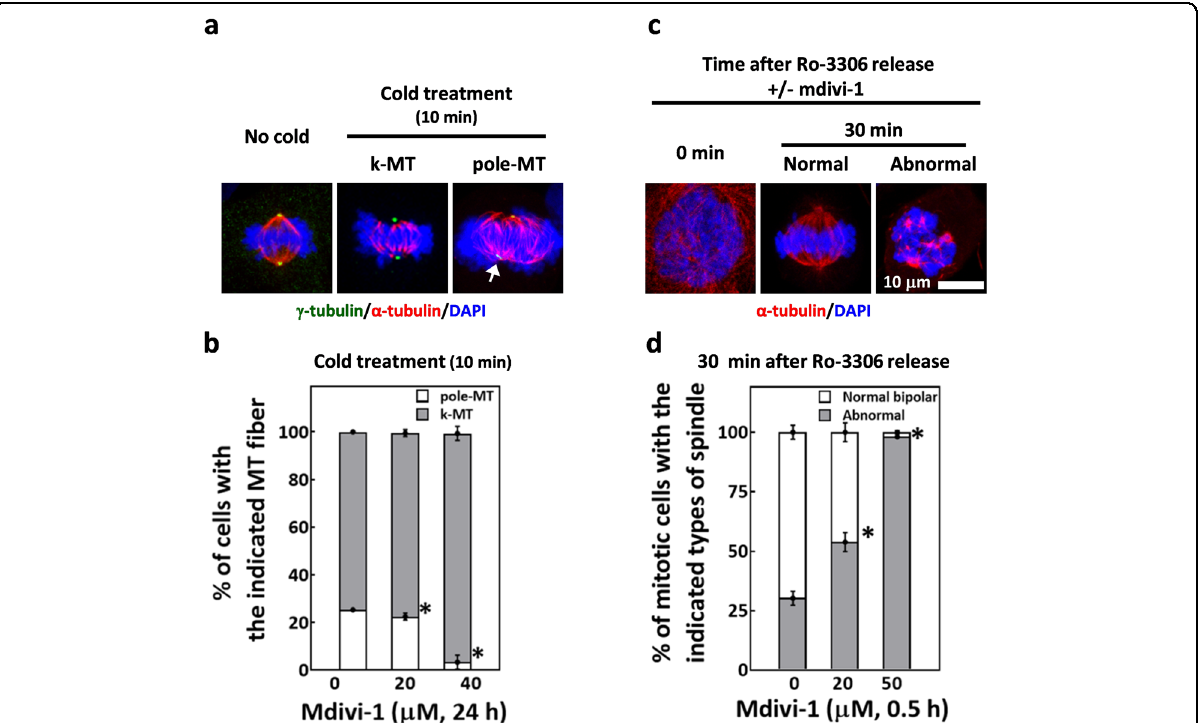
Fig. 6 Mdivi-1 sensitizes microtubules to cold-induced disassembly and immediately disrupts spindle assembly upon mitosis entry. a Representative image of cells fi xed without cold treatment (no cold) and those fi xed after 10 min cold treatment are shown. For 10-min cold- treated cells, images are representative of those with kinetochore-microtubule (k-MT) and those with spindle microtubule remnants at the spindle pole (pole-MT, white arrow). The spindle was revealed by immunostaining for γ -tubulin (green), α -tubulin (red), and chromosomes (blue). b Mdivi-1- sensitized cells to cold-induced disassembly of spindle pole microtubules. The cells were treated with mdivi-1 as indicated, followed by 10 min cold treatment. Cells were then subjected to analysis of mitotic spindles. The percentages of cells containing the indicated types of microtubule are shown. Data are presented as mean ± SD from three independent experiments. * p < 0.05 comparing to 0 μ M mdivi-1 by Student ’ s t test. c Images of Ro-3306-blocked-and-released mitotic cells. Representative images are shown of mitotic cells that were fi xed immediately after release (0 min) with no spindle assembly and those fi xed after release for 30 min with assembled spindles (30 min, Normal) or abnormal spindles (30 min, Abnormal). d Mdivi-1 disrupted bipolar spindle assembly rapidly after cells entered mitosis. Cells were fi rst blocked with Ro-3306 and then released from the block for 30 min in the absence or presence of mdivi-1. The percentages of mitotic cells with the indicated types of the spindle are shown. Data are presented as mean ± SD from three independent experiments. * p < 0.05 comparing to 0 μ M mdivi-1 by Student ’ s t